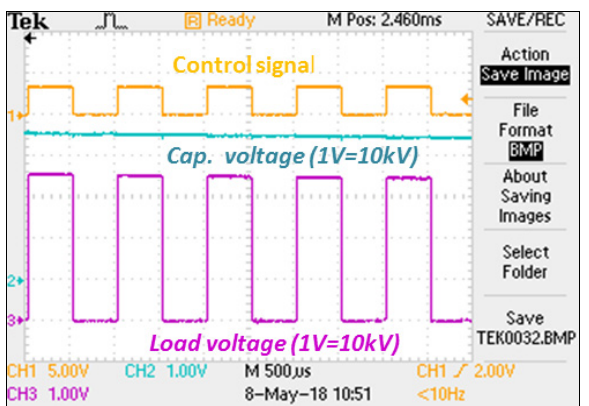
Fig. 8: Test result of 35 kV at 1 kHz Modulation